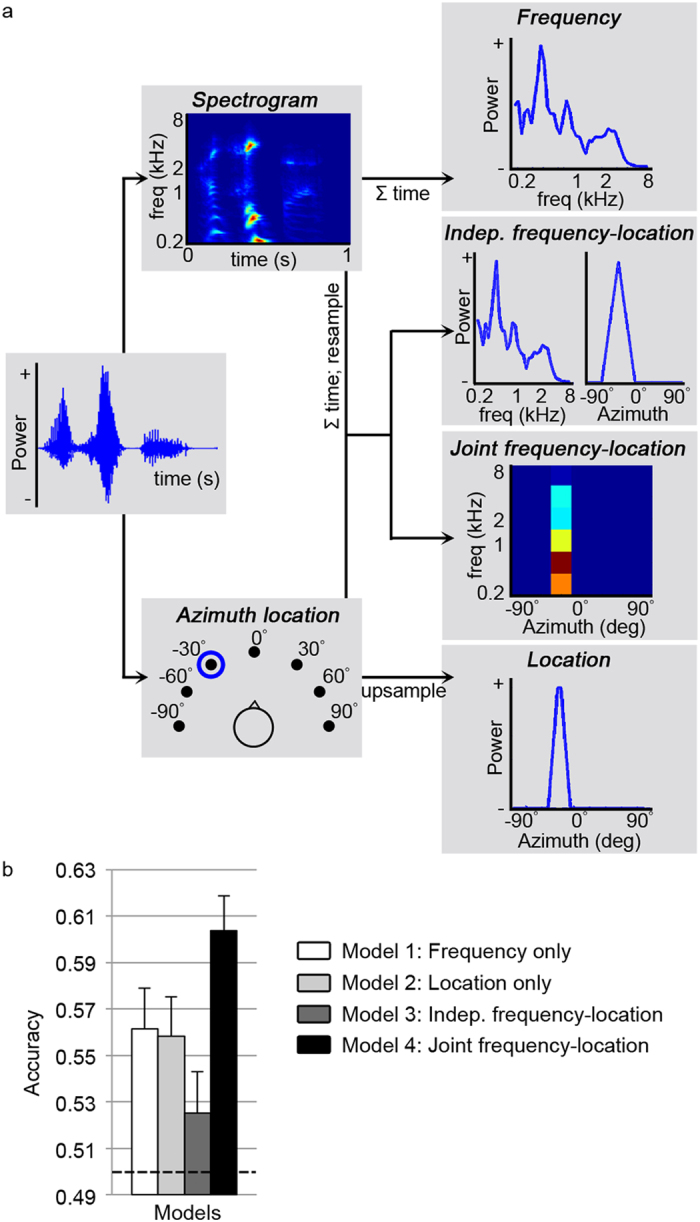
Overview and performance of encoding models.(a) The sounds were represented by four computational models. Top: The sound representation in the frequency only model space was obtained by averaging the sound’s spectrogram over time. Second row: For the independent frequency-location model, the representation of the sound in the frequency space was concatenated with a vector representing the sound’s location. Third row: The joint frequency-location model was obtained by setting the bins representing the sound’s location to the values reflecting the sound’s frequency content. Bottom: The stimulus representation in the location only model space was obtained by upsampling a vector representing the sound’s location. (b) Bars indicate the prediction accuracy for the four models across subjects (mean + s.e.m., N = 6). The frequency only, location only and the joint frequency-location model performed significantly above chance. However, the joint frequency-location model was significantly better at representing the fMRI data than the single feature models (see Supplementary Fig. 3 for individual subject results). Chance level is 0.5 and is indicated by the dashed black line.